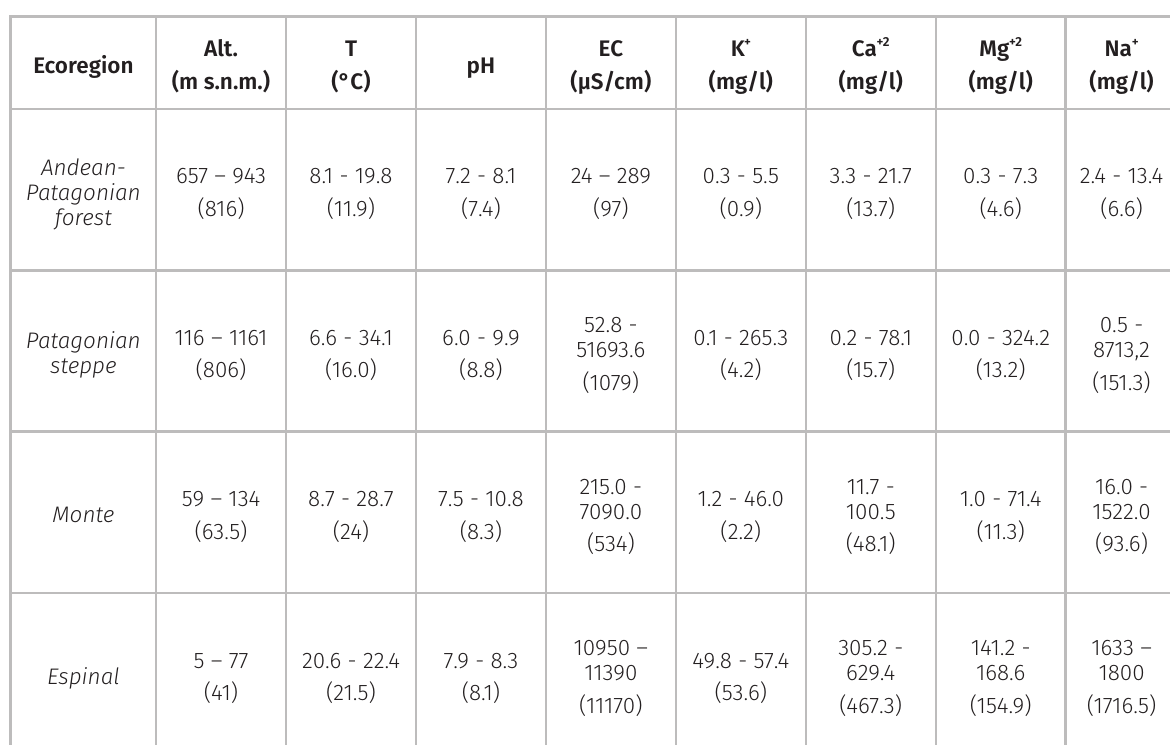
Table VI. Range of examined parameters in the different ecoregions, median values in parenthesis. Abbreviations: T = temperature, EC = electrical conductivity, Alt. = altitude.